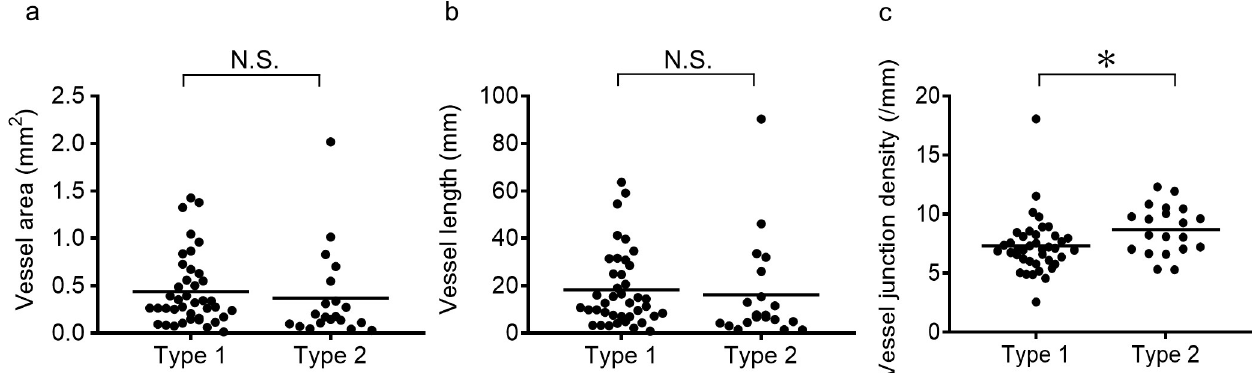
Fig 5. Quantitative and qualitative choroidal neovascularization (CNV) analyses. Vessel area (a), vessel length (b), and vessel junction density per length (c) of type 1 and type 2 CNVs. � Statistically significant difference (P < 0.05). N.S., not significant.